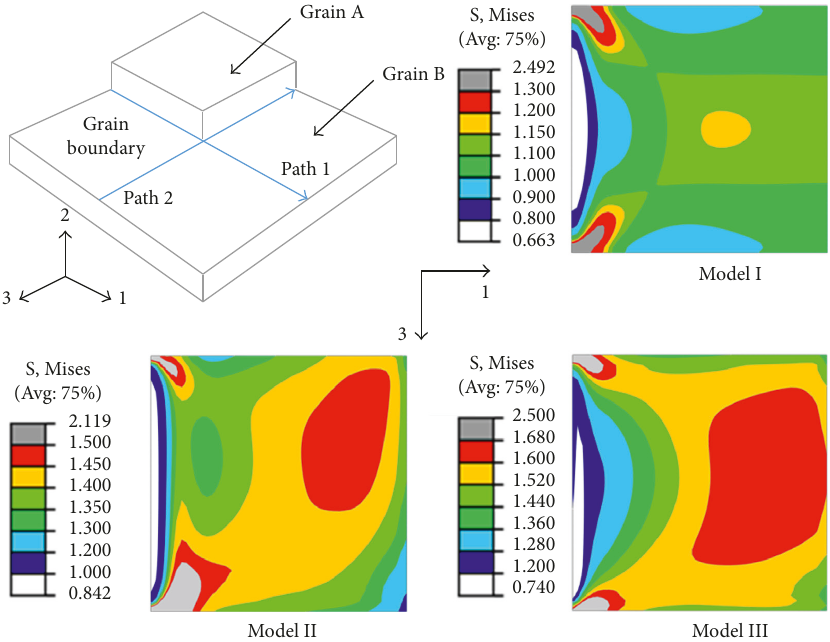
Figure 12: Mises stress distribution on the GB of grain B for type-II